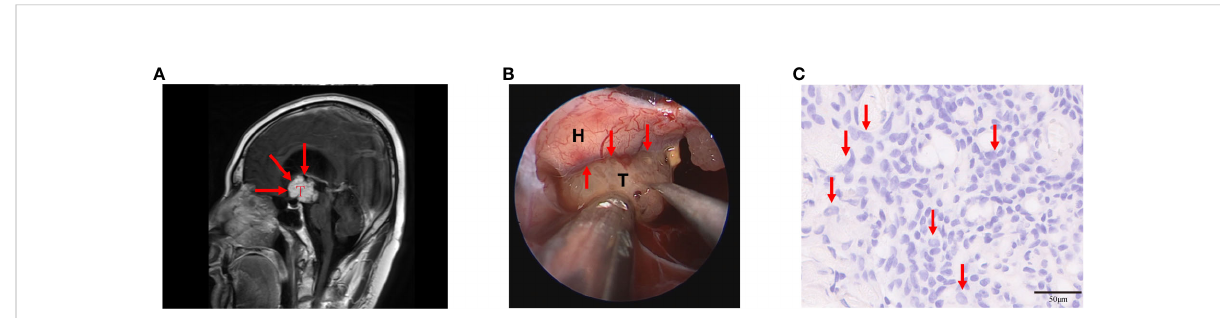
FIGURE 1 Puget grade 2 papillary craniopharyngioma (PCP) tumor with magnetic resonance imaging (MRI) image, surgical fi ndings, and histopathological results. (A) This tumor caused the dislocation, compression, and destruction of the hypothalamus as shown in the MRI image (indicated by the red arrow), T: PCP tumor. (B) The tumor was surrounded by edema, its brittleness was increased, and a considerable amount of yellow fi brin exuded from the tumor during the operation (indicated by the red arrow), T: PCP tumor, H: hypothalamus. (C) Histopathology showed abundant neutrophils in fi ltrated in tumor tissue (indicated by the red arrow), hematoxylin-eosin staining